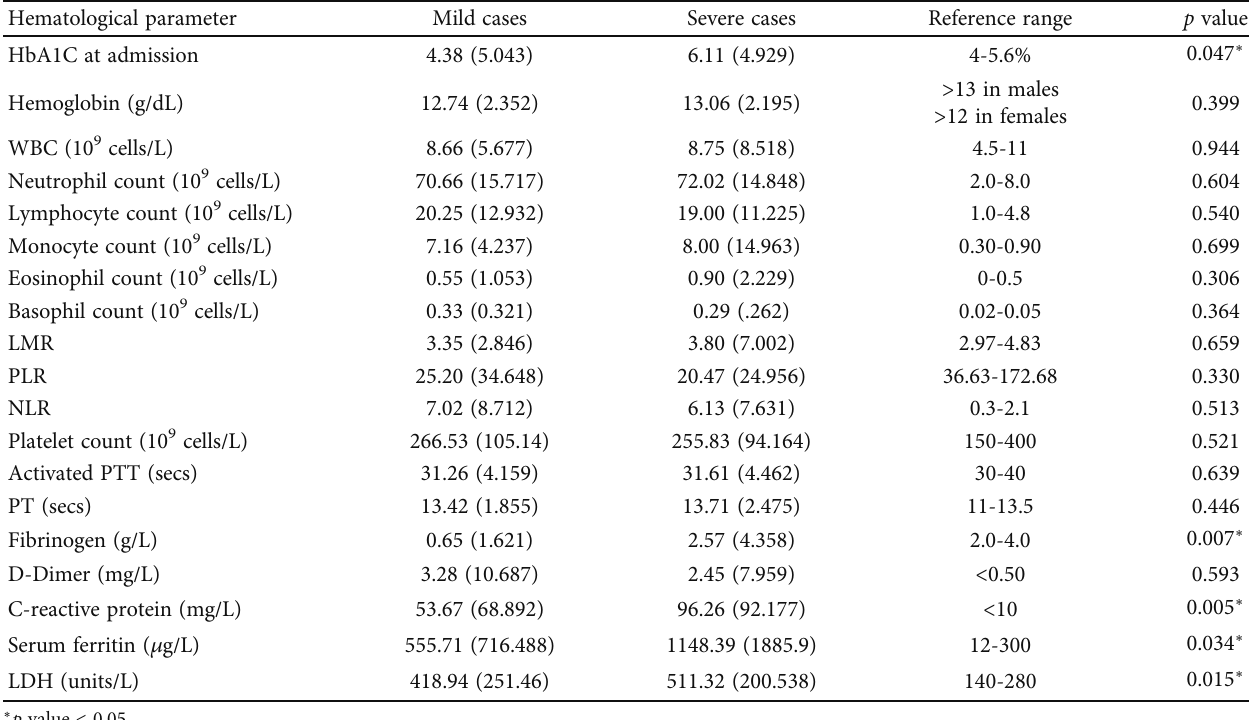
Table 3: Hematological parameters of mild and severe patients with COVID-19 infection and diabetes mellitus at the time of admission. Hematological parameter